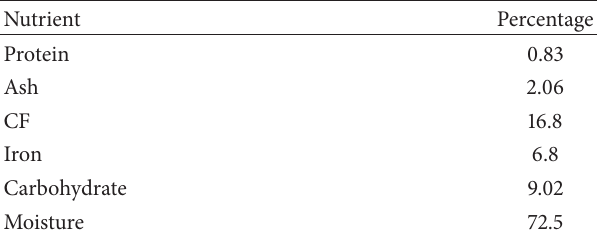
Table 5: Nutrient composition of D. steriscus .